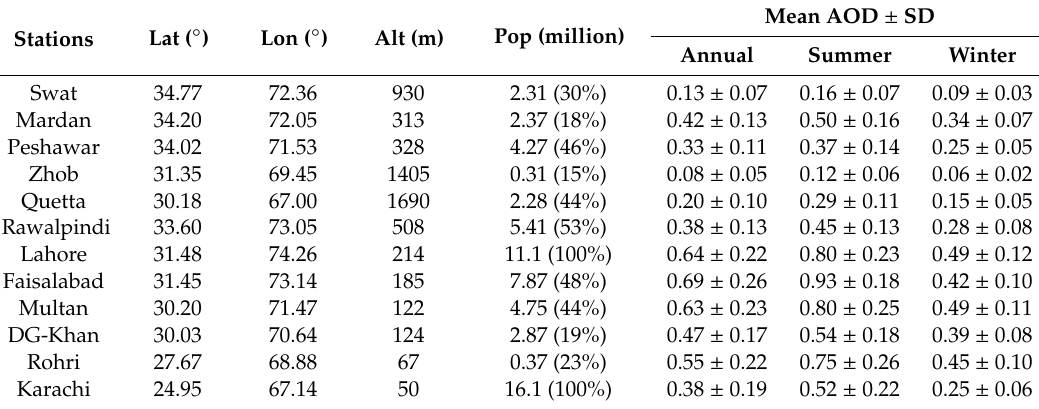
Table 1. Information of selected regions, multiyear mean AOD (2003–2017); annual, summer (JJAS) and winter (DJF) along with standard deviations (SD) from the mean, acquired from MODIS-Terra DB product. The Population record (in millions) is based on 2017 census [46]; the numbers in brackets show the urban percentage for each